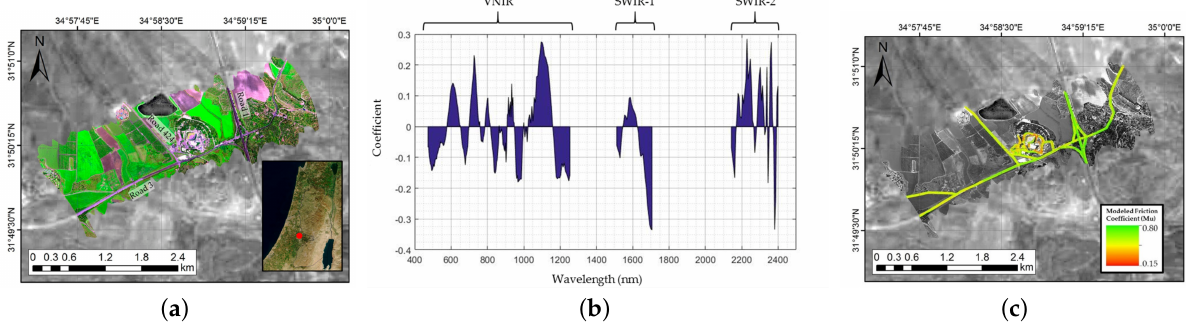
Figure 8. ( a ) Location selection, ( b ) coefficient spectra of the band weights in the model, and ( c ) predicted friction coefficient values for the study site map